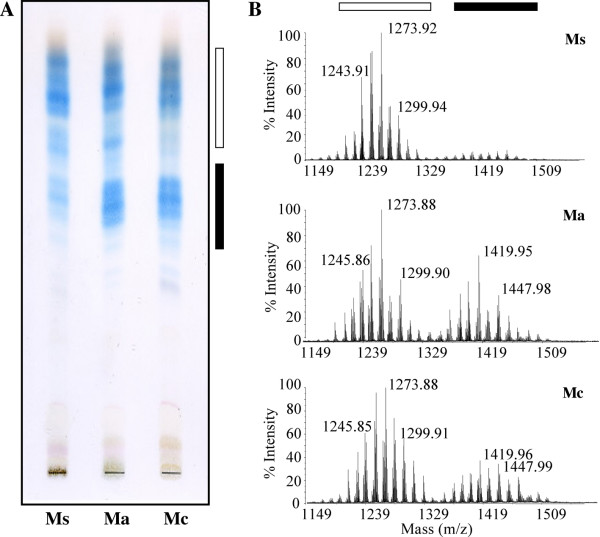
A) Thin-layer chromatography analysis of the crude lipid extract of M. smegmatis (Ms), M. abscessus (Ma), and M. chelonae (Mc). Open rectangle, diglycosylated GPLs; closed rectangle, triglycosylated GPLs. B) MALDI-TOF mass spectra of the crude lipid fractions of M. smegmatis (Ms), M. abscessus (Ma), and M. chelonae (Mc). Open rectangle, diglycosylated GPLs; closed rectangle, triglycosylated GPLs.